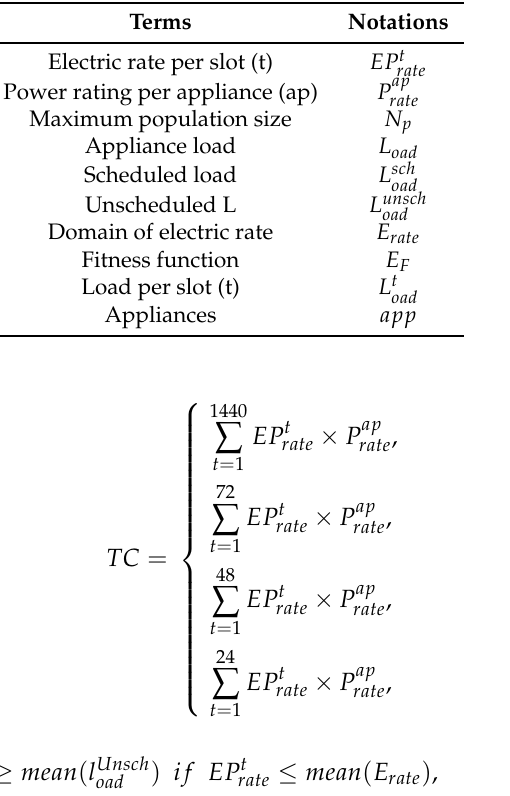
Table 2. Terms used in equations and their